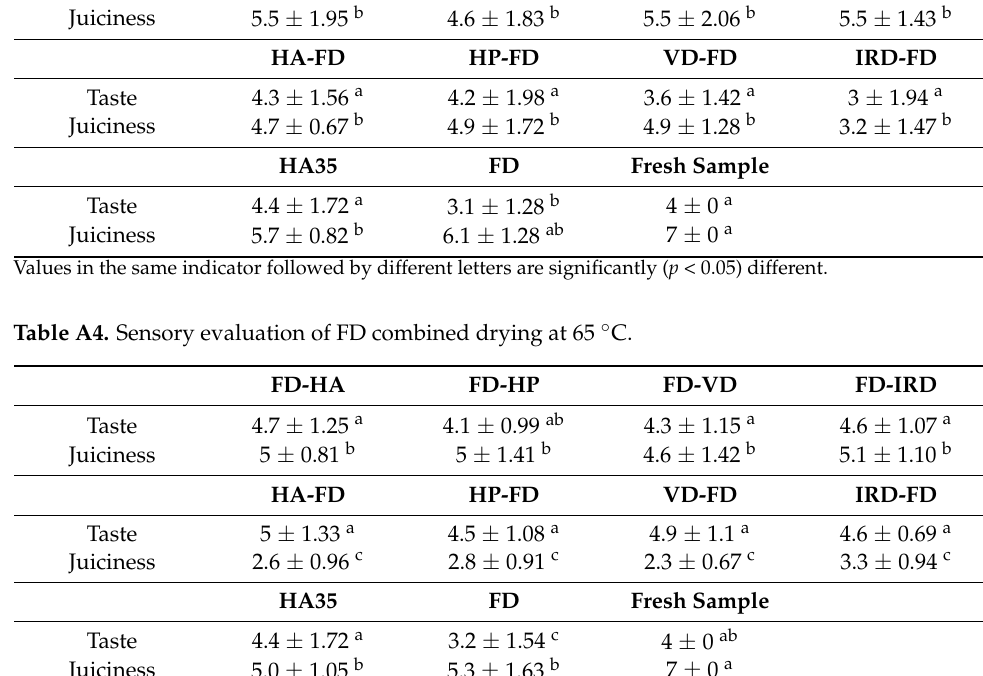
Values in the same indicator followed by different letters are significantly ( p < 0.05)